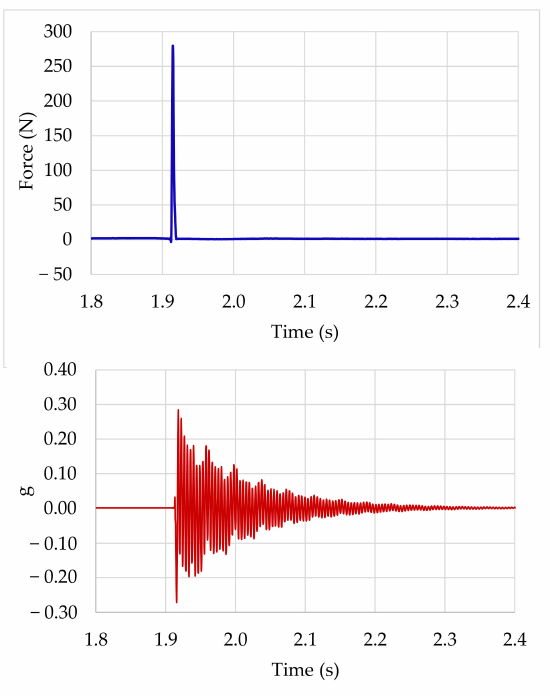
Figure 1. Input-output graphic from an impact